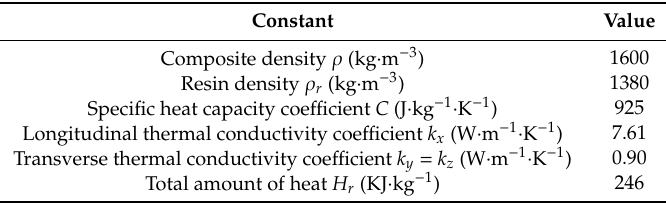
Table 1. Thermal properties of T800HB / 3900-2 composite.